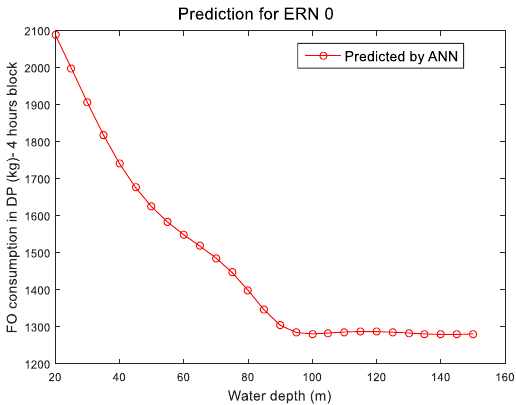
Figure 4. ANN-predicted FO consumption for ERN 0.